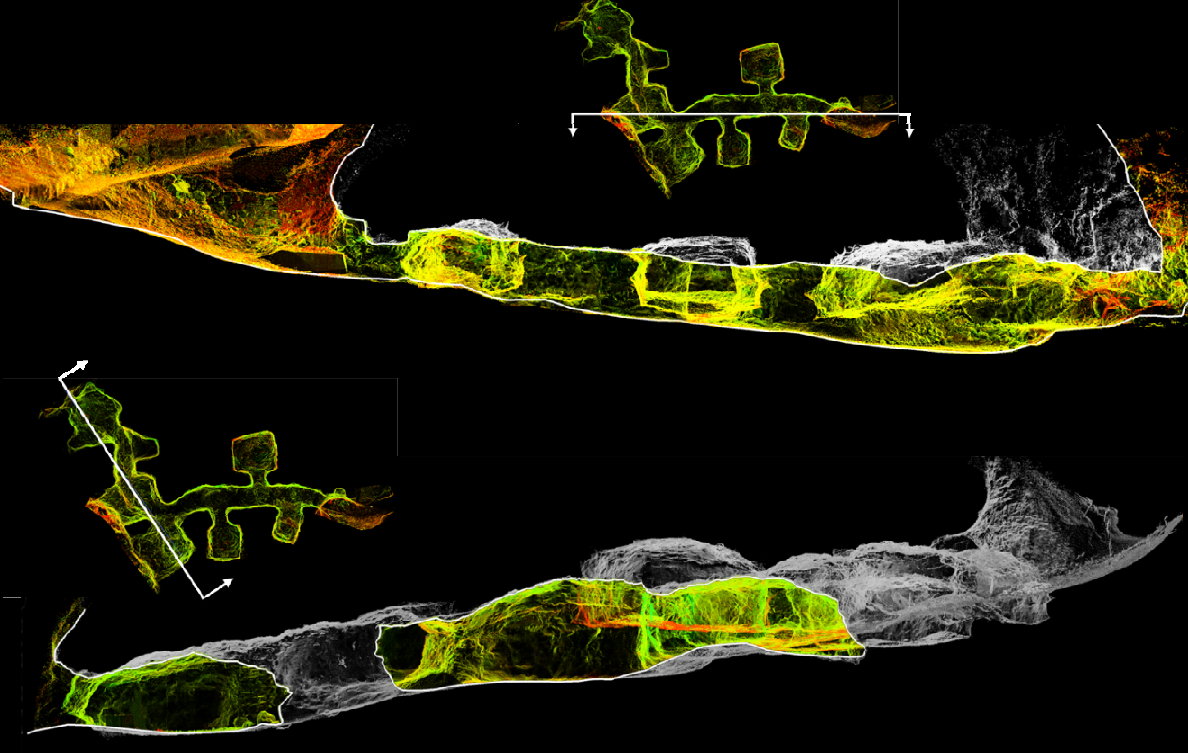
Figure 9. The hypogeum system: visualizations and cross sections of the 3D point cloud.